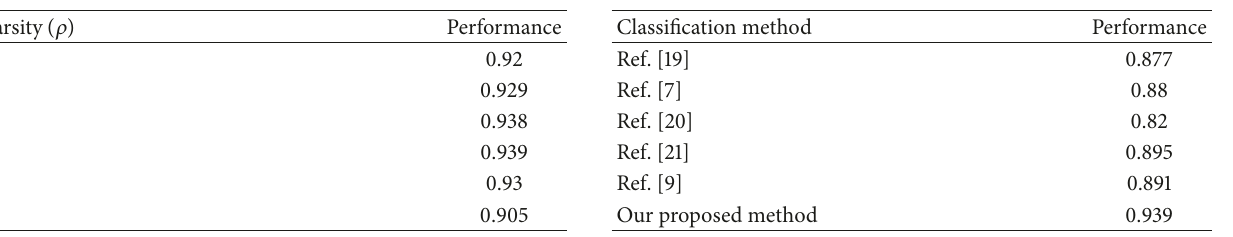
Table 5: The effect of model sparsity.